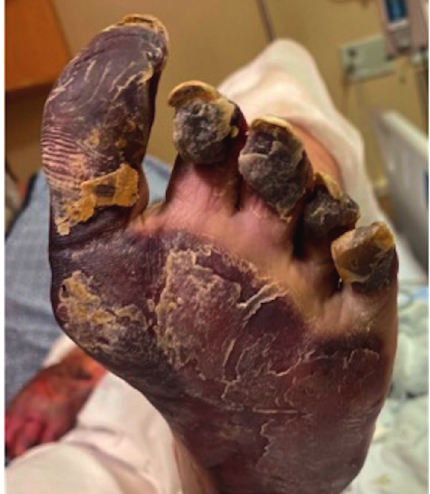
Figure 2: Patient’s foot on initial presentation.